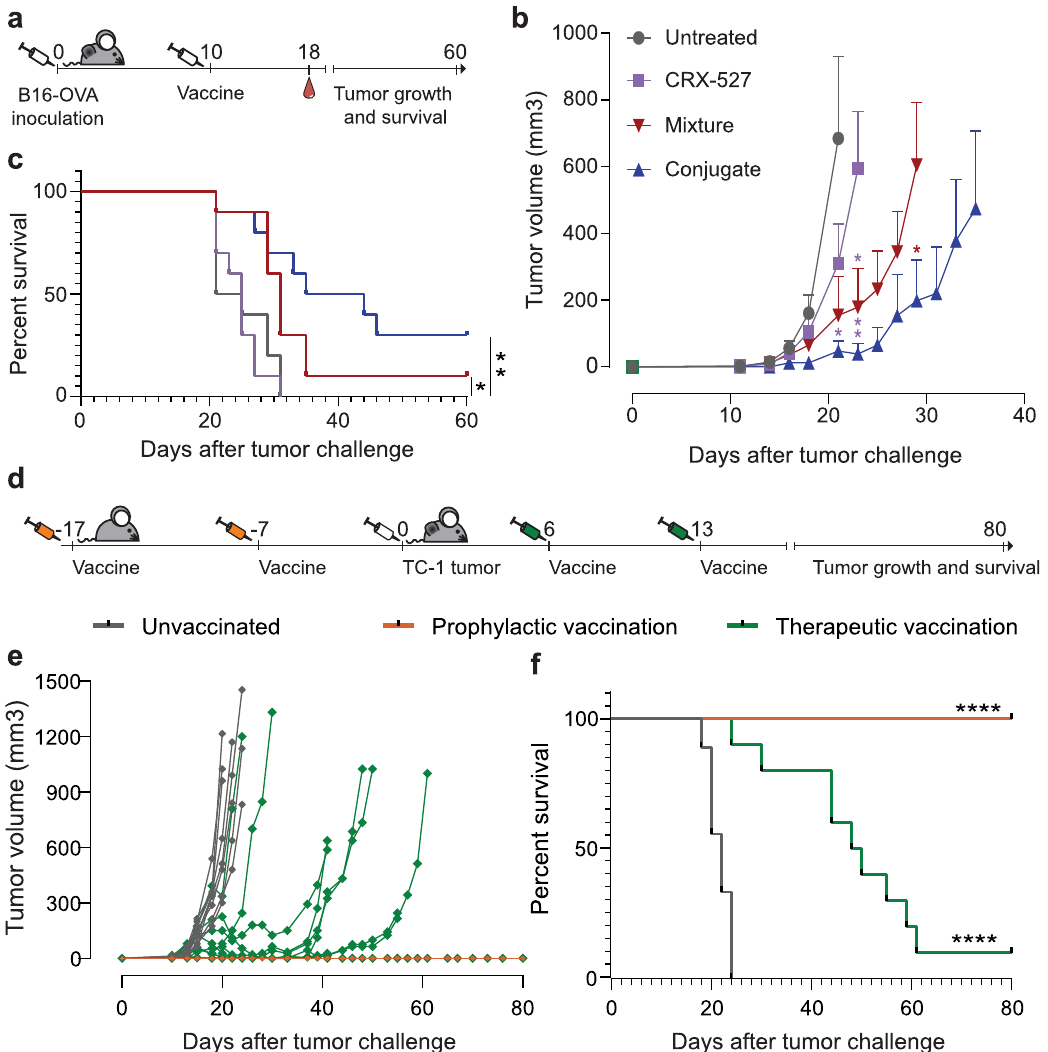
Fig. 5 Therapeutic vaccination with CRX-527 conjugates results in effective therapeutic activity. a Schematic overview of the experiment. Mice ( n = 10 per group) were injected with 100,000 B16OVA tumor cells. Once tumors were palpable, mice were vaccinated with 1 nmol of CRX-527, a mixture of CRX-527 and OVA CTL and Help peptides or the two OVA CTL and Help conjugates. Blood was withdrawn at day 18 to monitor the induction of SIINFEKL-speci fi c CD8 responses by tetramer staining. b Average (±SD) B16OVA tumor growth in the different therapeutic vaccination groups. Statistical signi fi cance between Lipid A, mix and conjugates at different time points was calculated by one- way ANOVA and Tukey ’ s multiple comparison. The color of the stars indicates to which group the statistical signi fi cance is referred to. * p